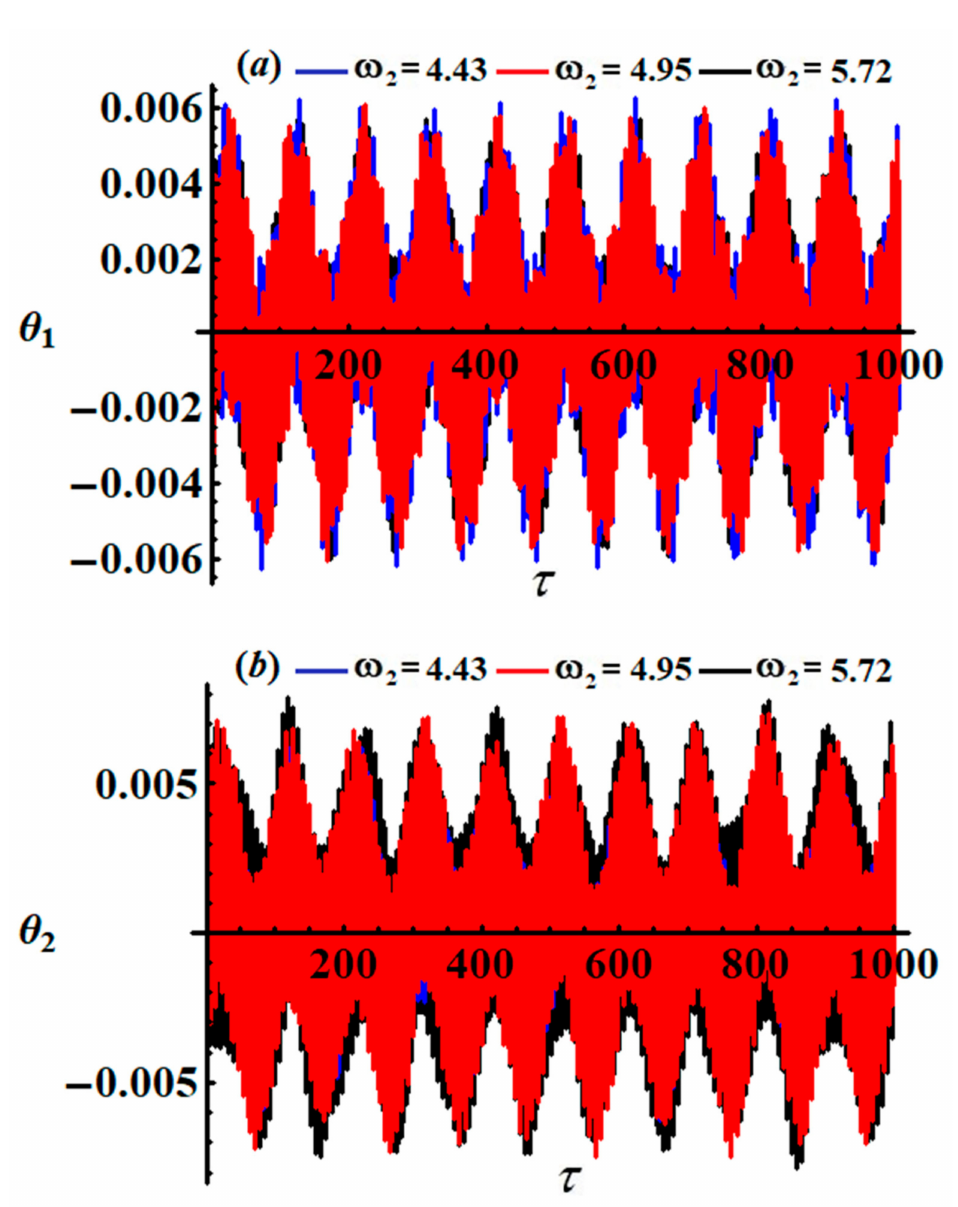
Figure 5. Description of the time histories of the solutions at ω 2 = ( 4.43,4.95,5.72 ) : ( a ) for θ 1 , ( b ) for θ 2